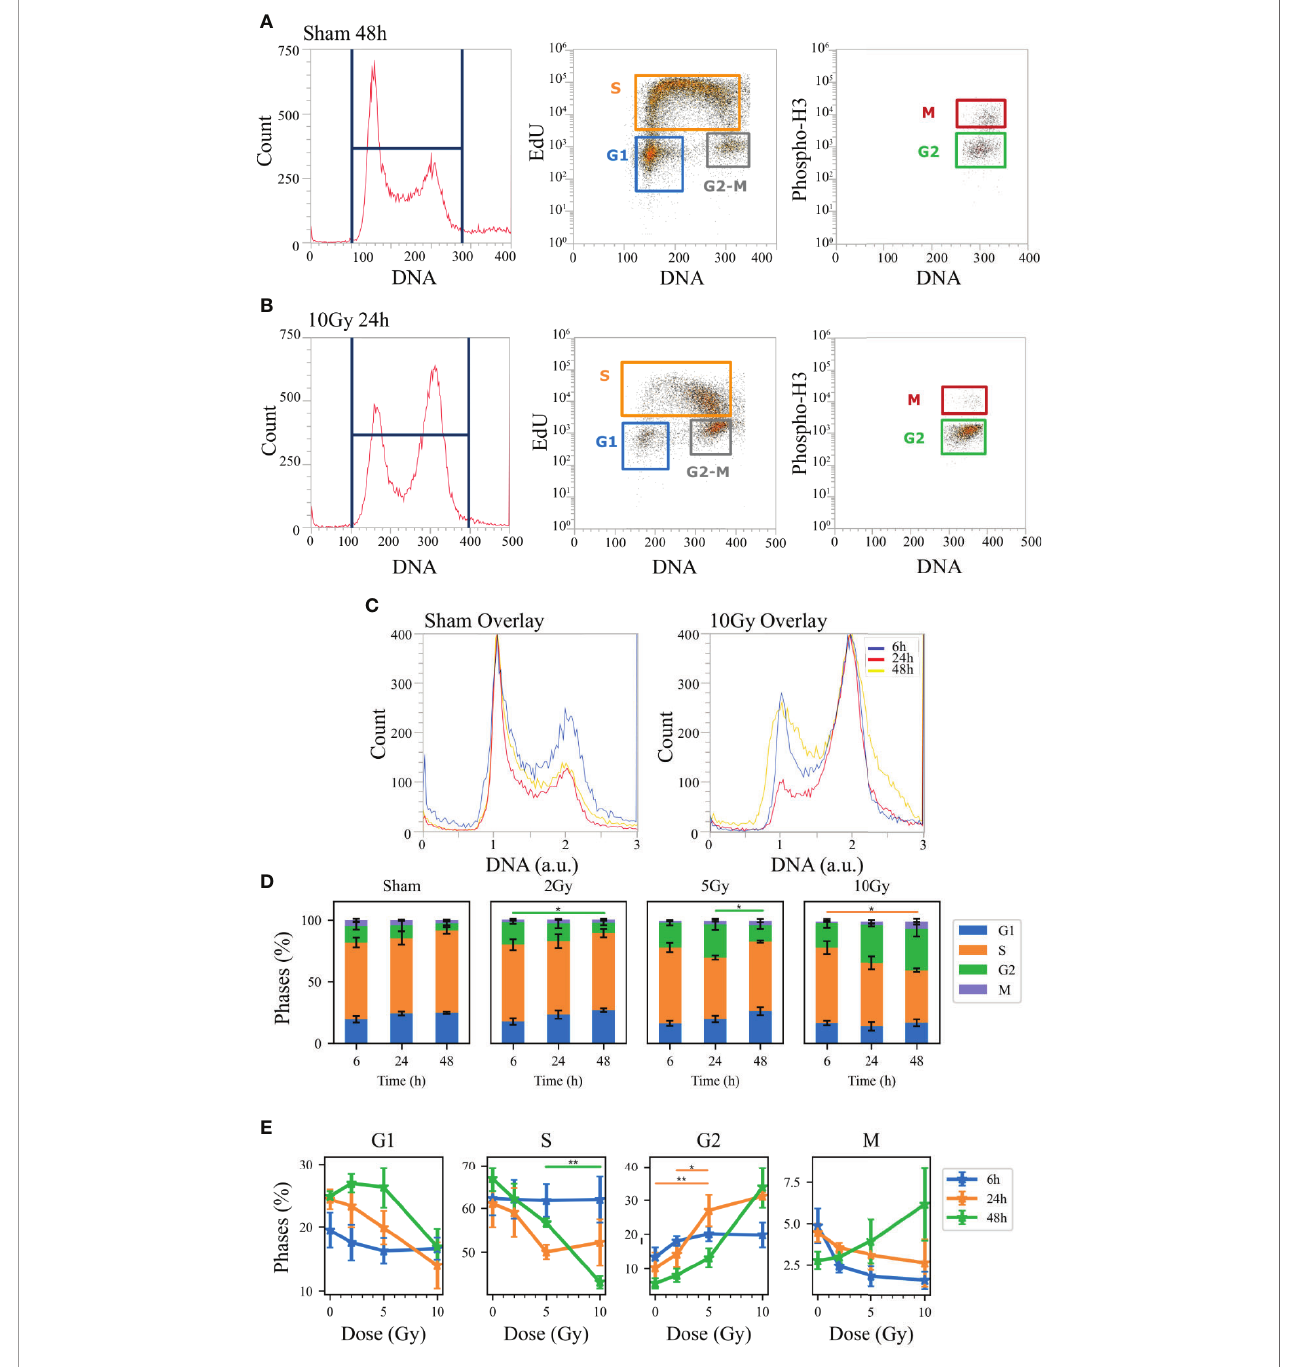
FIGURE 4 | Cell cycle analysis with fl ow cytometry following the “ Seed + Treat ” protocol. Hierarchical gating strategy for the distribution of Caco-2 cells in the cell cycle demonstrated with illustrative data for: (A) Sham condition at 48 h; (B) 10-Gy-irradiated cells at 24 h. From left to right in both panels: monoparametric distribution of FxCycle violet signal with gate on all cells; biparametric plot of EdU vs. FxCycle signals for all cells with gates on G 1 , S and G 2 /M phases; biparametric plot of Phospho-H3 vs. FxCycle signals for all G 2 /M cells with gates on G 2 and M phases. (C) Illustrative relative DNA content distributions for the whole cell population (average FxCycle signal for cells in G1 normalized to 1) for the sham (left) and 10-Gy condition (right) overlayed at different time points. (D) Percentages of cells in G 1 , S, G 2 and M for the different irradiation conditions as a function of time. (E) Percentages of cells in each phase for the different time points as a function of X-ray dose (same data as in panel D, lines are a guide to the eye). Data are mean ± SEM, obtained from ≥ 3 independent experiments. Statistical signi fi cance (post-hoc pairwise comparisons with Bonferroni correction) is as follows: *p < 0.05, **p <